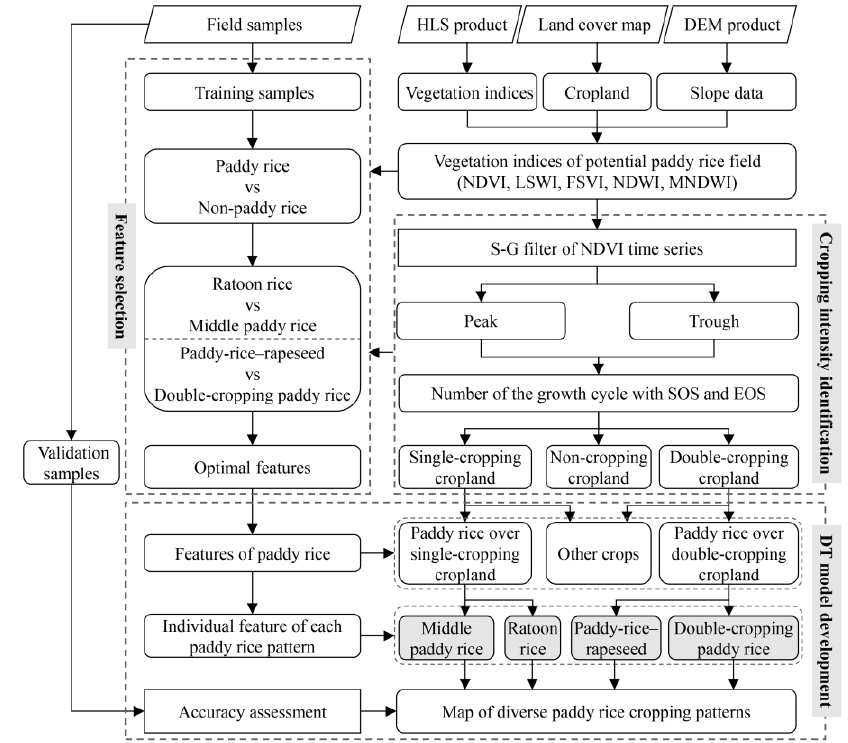
Figure 3. Workflow of the FSHC method for mapping diverse PRCPs using the HLS